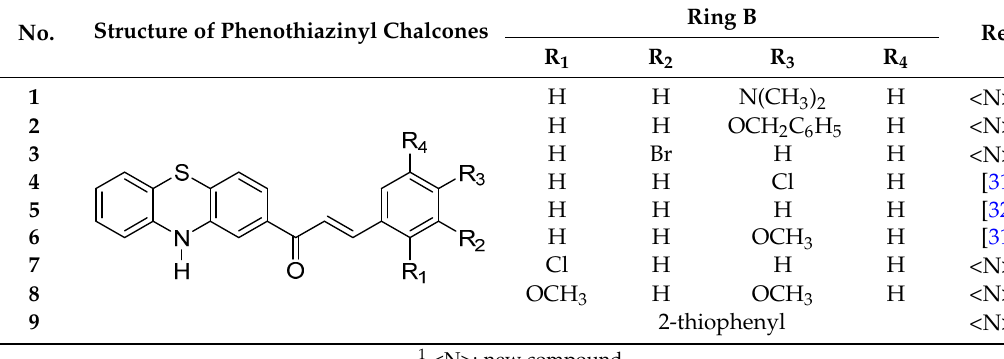
Table 2. Group of chalcone analogues with ring A as thiophene/furan/pyridine/phenyl moieties. No.